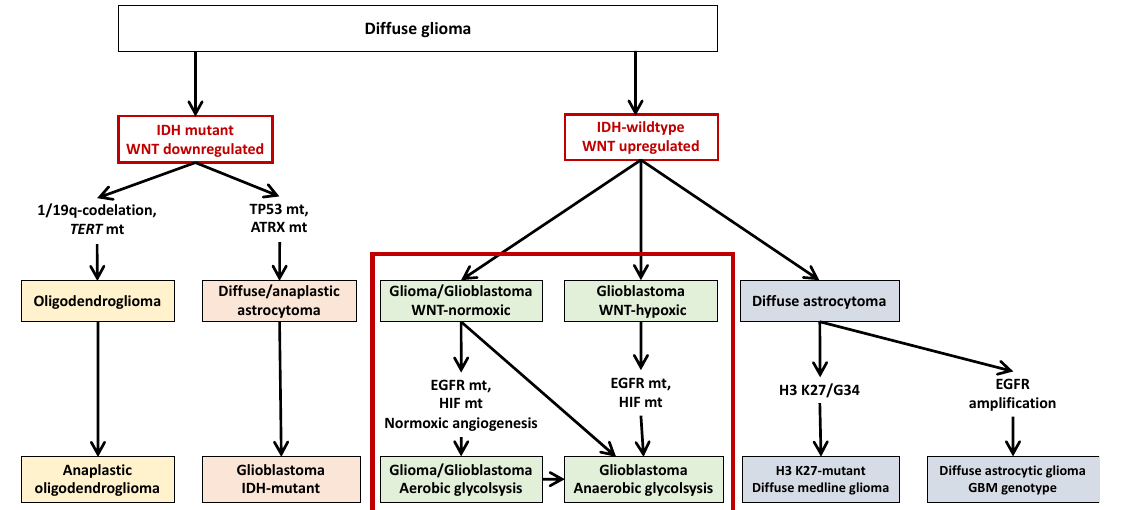
Figure 3. Features of diffuse glioma. In the 2016 WHO classification, diffuse astrocytic tumors and oligodendrogliomas can be defined by mutually exclusive genotypes (astrocytic, TP53 mt/ATRX mt; oligodendroglial, 1p/19q-codel/TERT mt) under the shared IDH mutation. IDH-wildtype tumors represent the main malignant glioblastoma or diffuse glioma genetically corresponding to glioblastoma. Our hypothesis is to add to this classification the notion of WNT pathway expression. IDH-mutant presents downregulation of the WNT pathway whereas IDH-wild-type presents upregulation of the WNT pathway. WNT pathway stimulation in the early stages of the tumor process is associated with normoxic glioma development with early angiogenesis